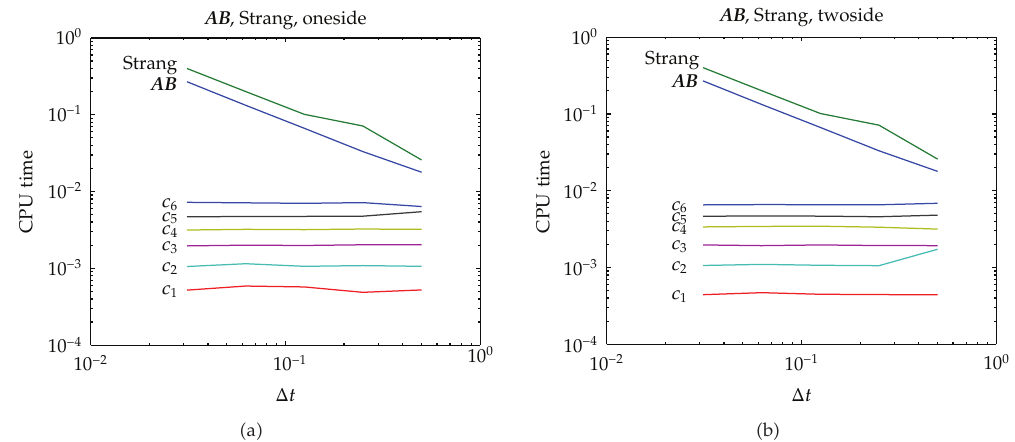
Figure 6: CPU time of the standard splitting scheme (cid:5) a (cid:6) and the iterative schemes (cid:5) b (cid:6) with 1 ,... , 6 iterative